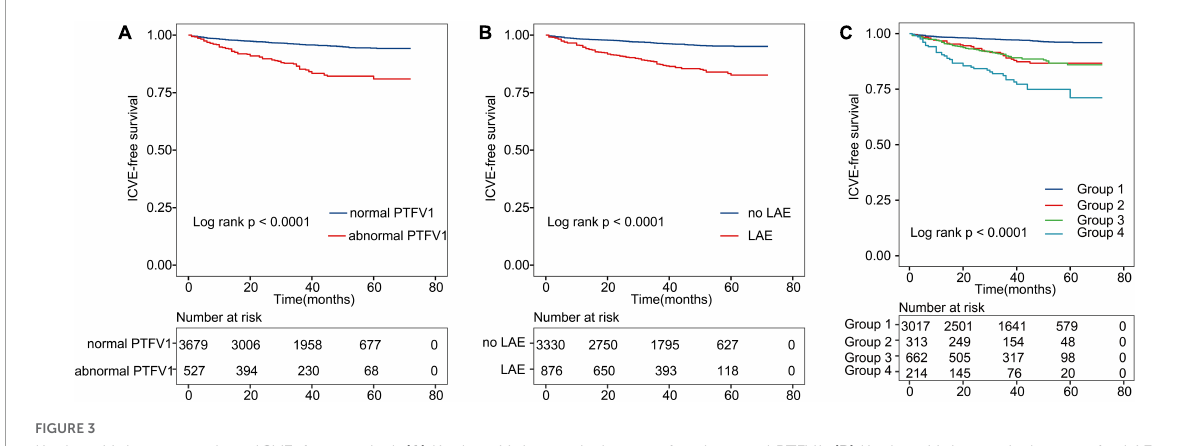
(PTFV1 and LAD) against the CHA 2 DS 2 -VASc score to discriminate the ICVE patients are indicated in Figure 4